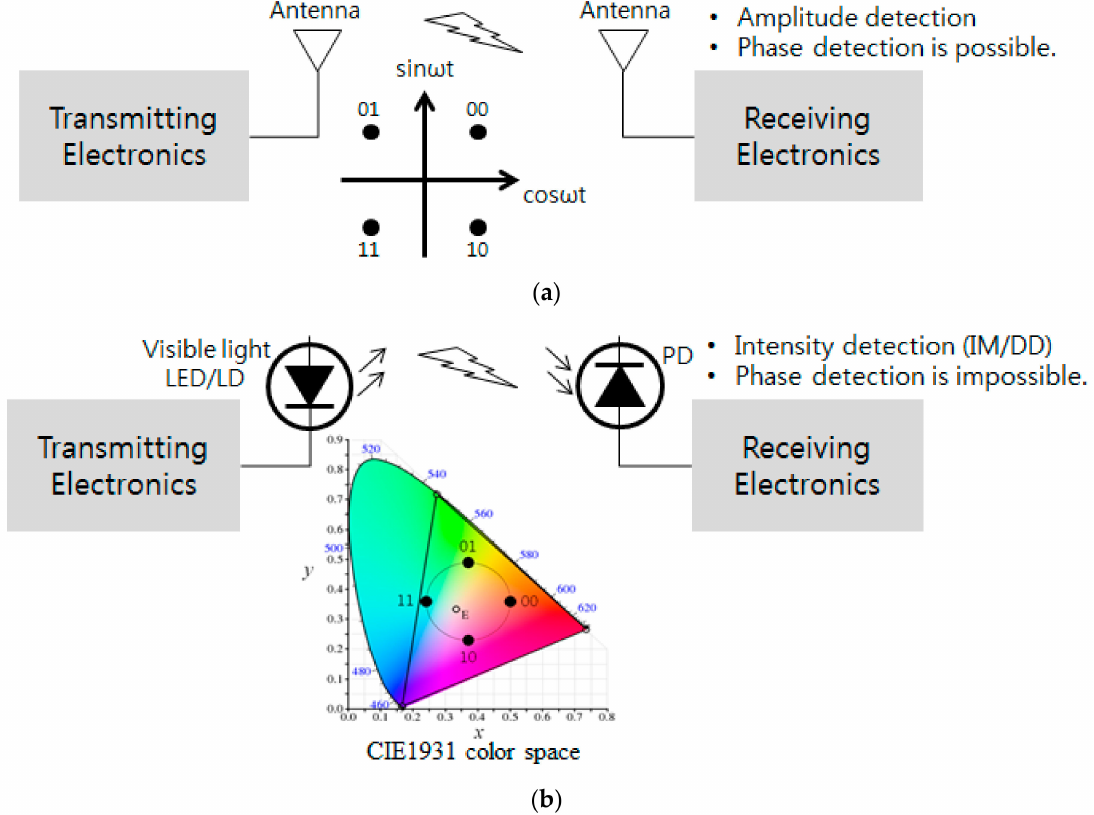
Figure 1. Color-space-based visible light communication (VLC) system vs. carrier signal-based RF system. ( a ) RF communication with carrier-based constellation; ( b ) VLC with color-space-based